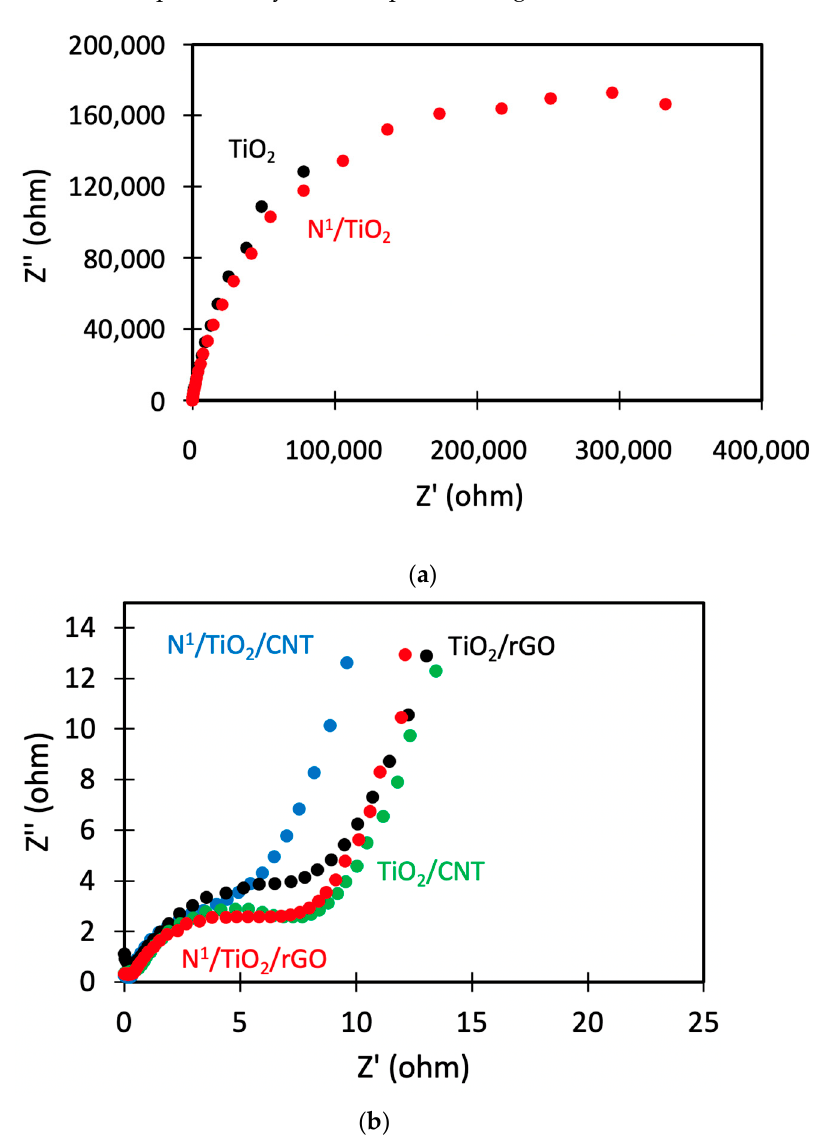
Figure 12. Electrochemical impedance spectra: ( a ) TiO 2 nanoparticles and N-doped TiO 2 nanoparticles, ( b ) TiO 2 /CNT, N-doped TiO 2 /CNT, TiO 2 /rGO and N-doped TiO 2 /rGO composites. cles, ( b ) TiO 2 /CNT, N-doped TiO 2 /CNT, TiO 2 /rGO and N-doped TiO 2 /rGO